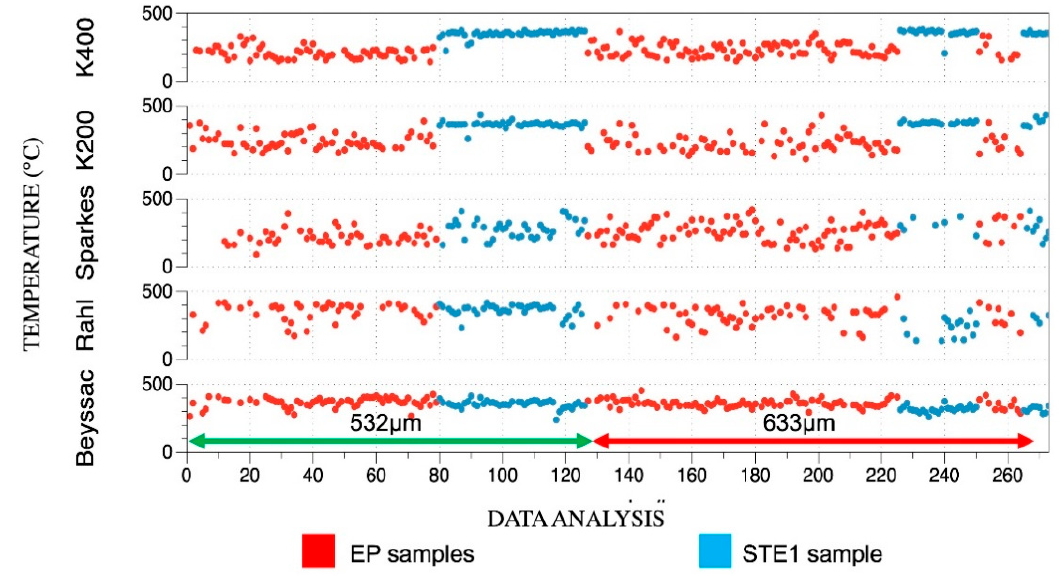
Figure 7. Comparison of the temperature estimates for samples STE1 and EPs using the five equations applied in this work (K200 = from [5] for 150 °C < T < 200 °C, and K400 = from [5] for 200 °C < T < 400 °C).